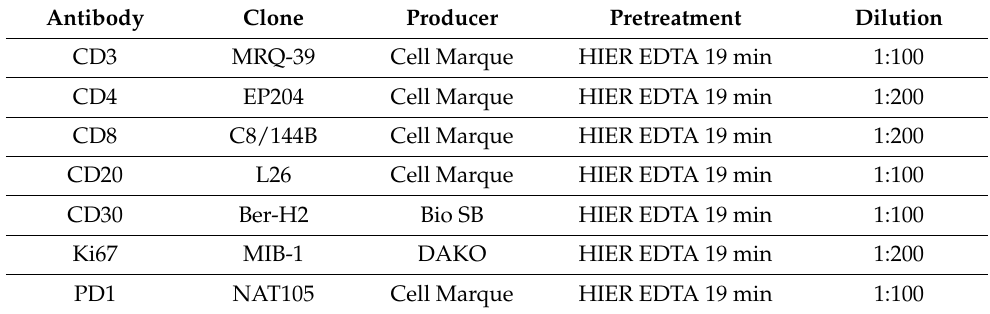
Table 1. The immunohistochemical markers.